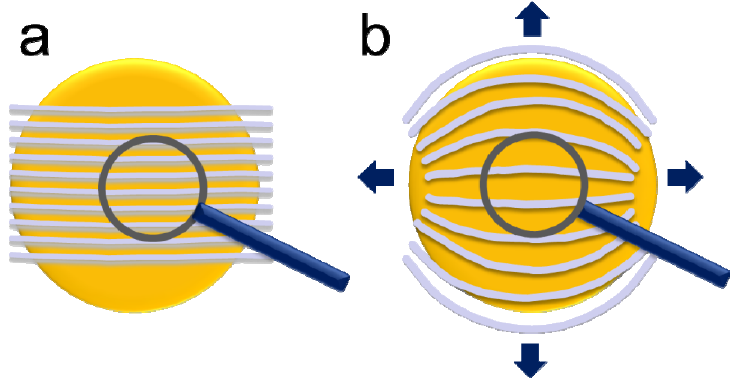
Figure 11. ( a ) Scheme of the density of polymer backbones of a flat surface. ( b ) After swelling of the surface area, the density of the polymer backbone is